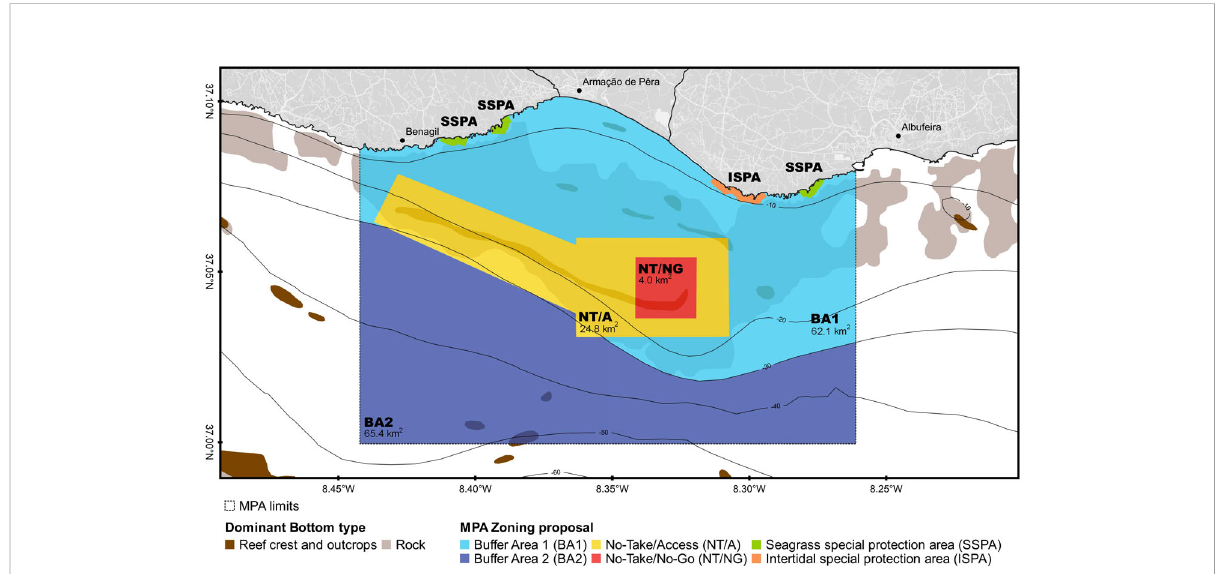
FIGURE 7 Second proposal of MPA zoning and respective general regulations as presented in the Intermediate zoning workshop (4th session of the multi- stakeholder